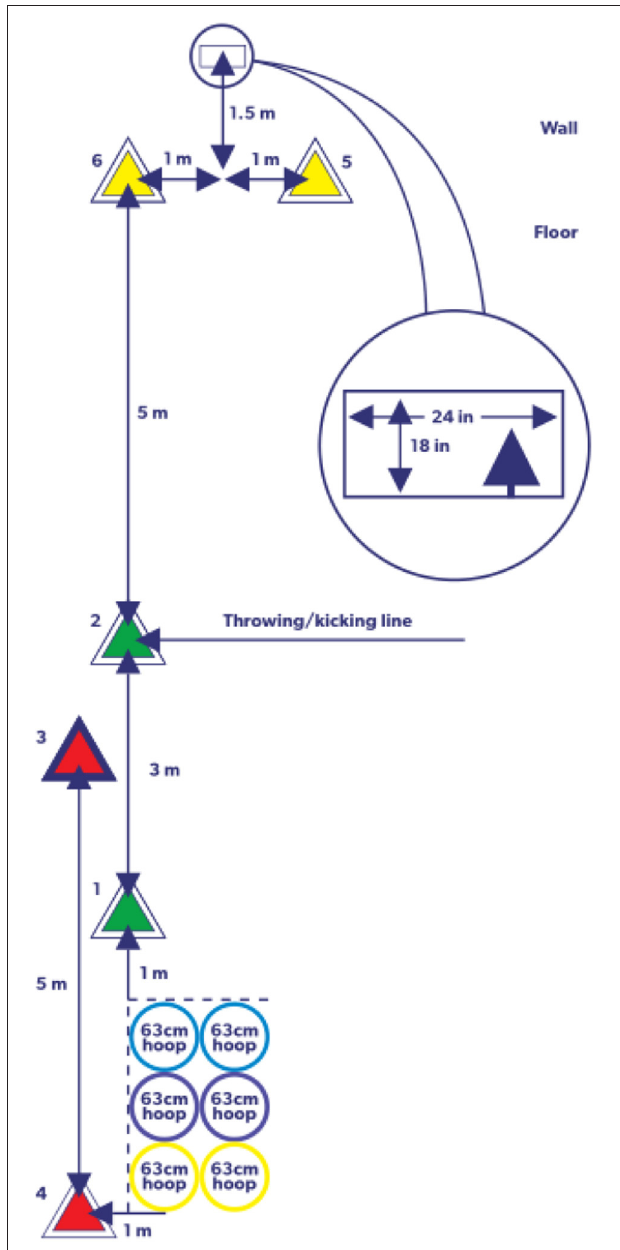
FIGURE 1 | CAMSA layout (CAPL-2